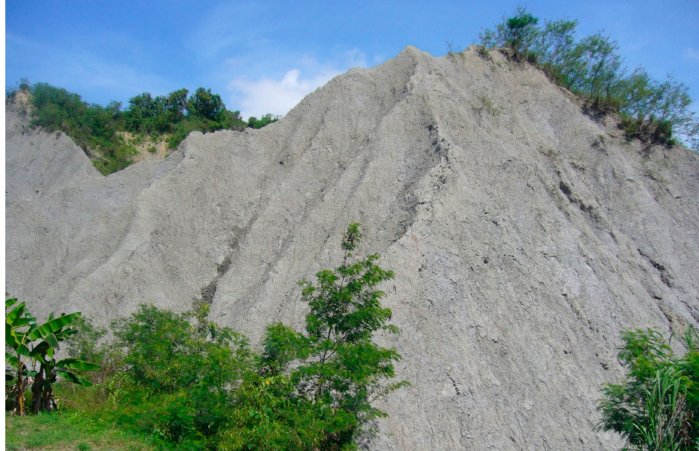
Figure 1. Rugged terrain of mudstone badland in southwestern